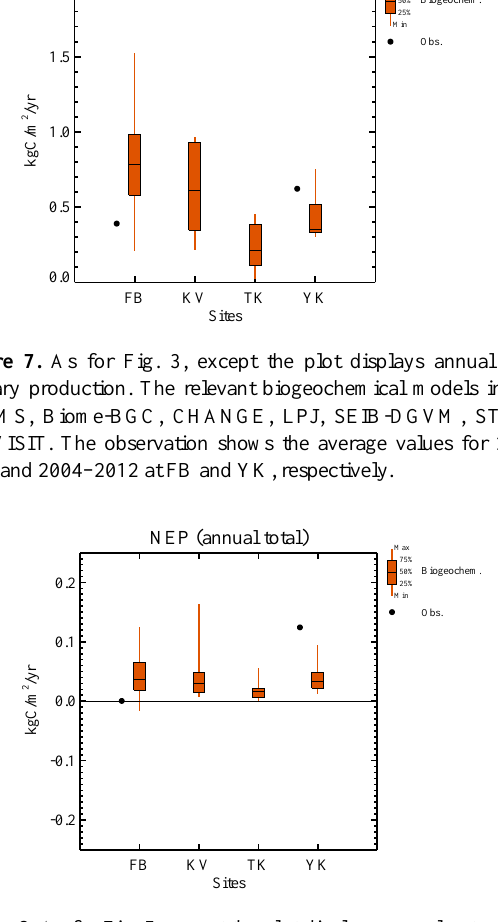
Figure 8. As for Fig. 5, except the plot displays annual net primary